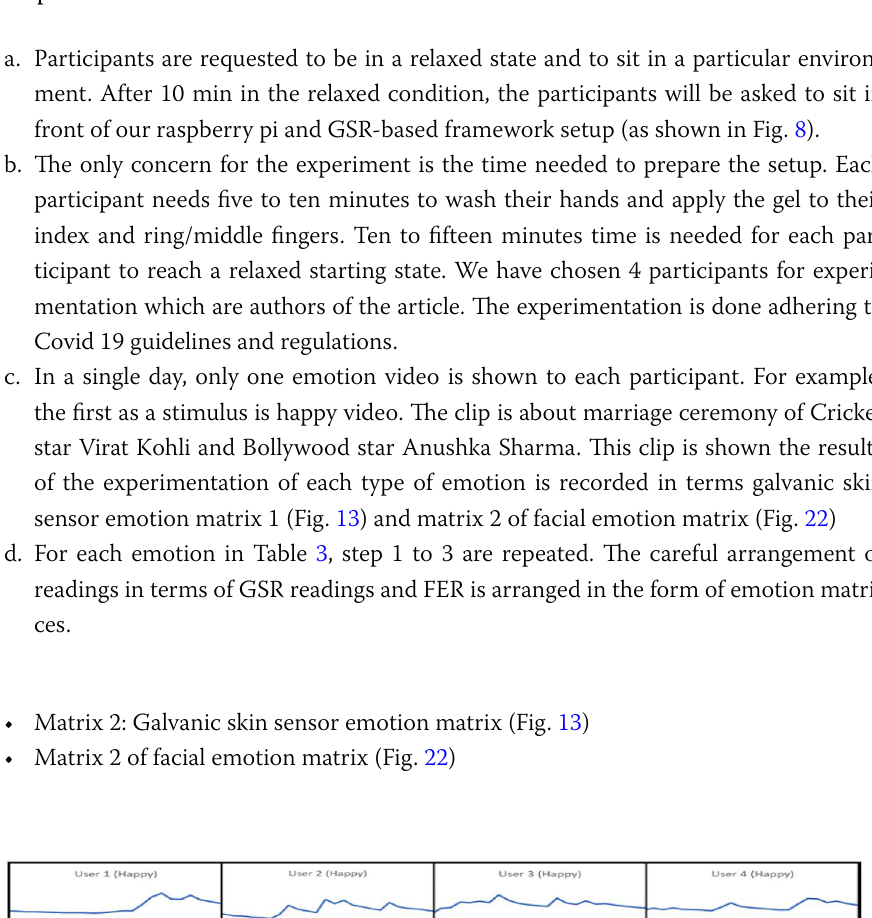
Experiment 1: Video induction stimuli method